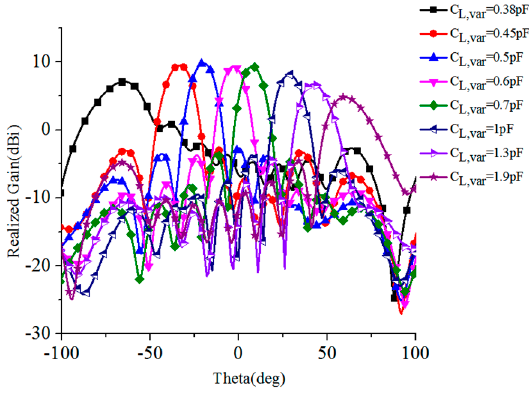
Figure 7. Simulated radiation patterns with capacitance varied from 0.38 pF to 1.9 pF.